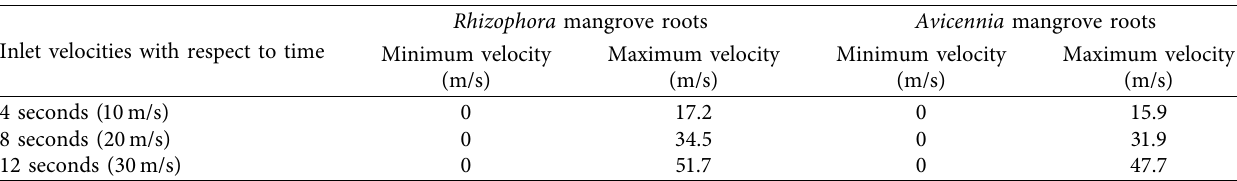
Table 4: The minimum and maximum velocity of flow around Rhizophora and Avicennia mangrove roots at time intervals of 4 seconds, 8 seconds, and 12 seconds.